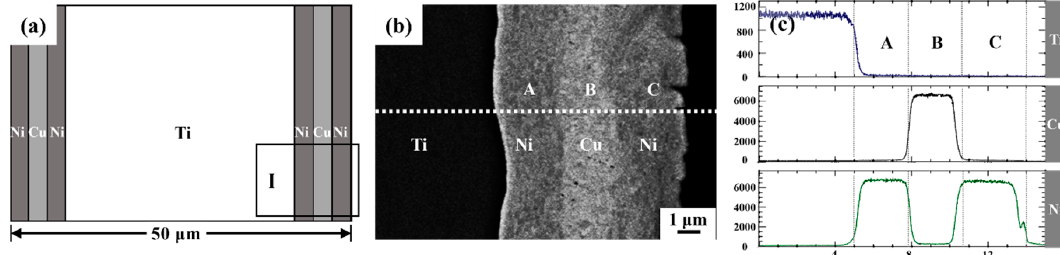
Figure 2. ( a ) The schematic diagram of a brazed joint before brazing illustrating center and edge locations of the joint; ( b ) an optical micrograph displaying the cross section of a whole joint after brazing.